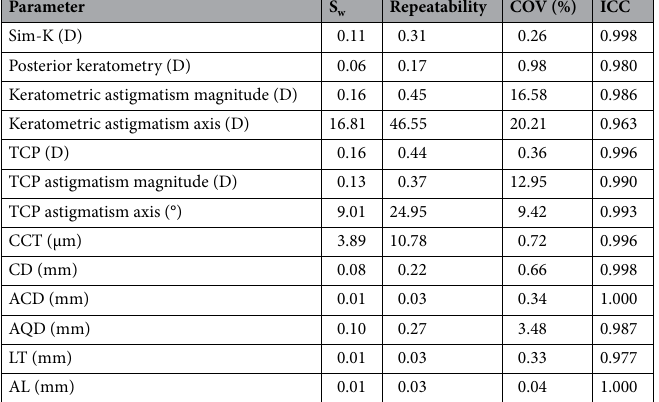
Table 1. Repeatability analysis of the measurements provided by AS-swept source OCT (ANTERION). Sw within-subject standard deviation, COV coefficient of variation, ICC intraclass correlation coefficient, Sim-K